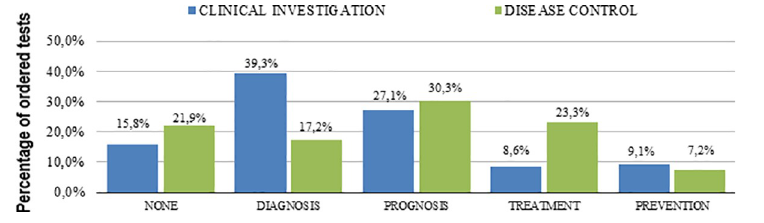
Fig 2. Tests usefulness according to reason for office